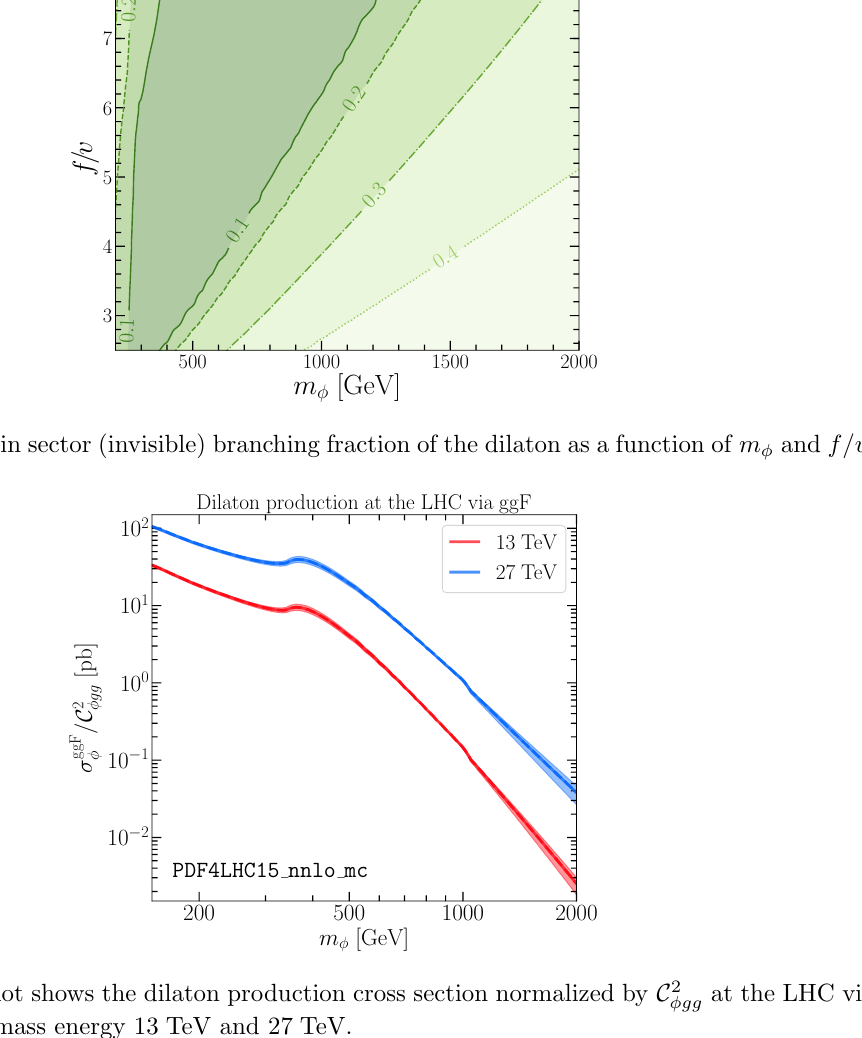
2 at the LHC via (cid:30)gg C